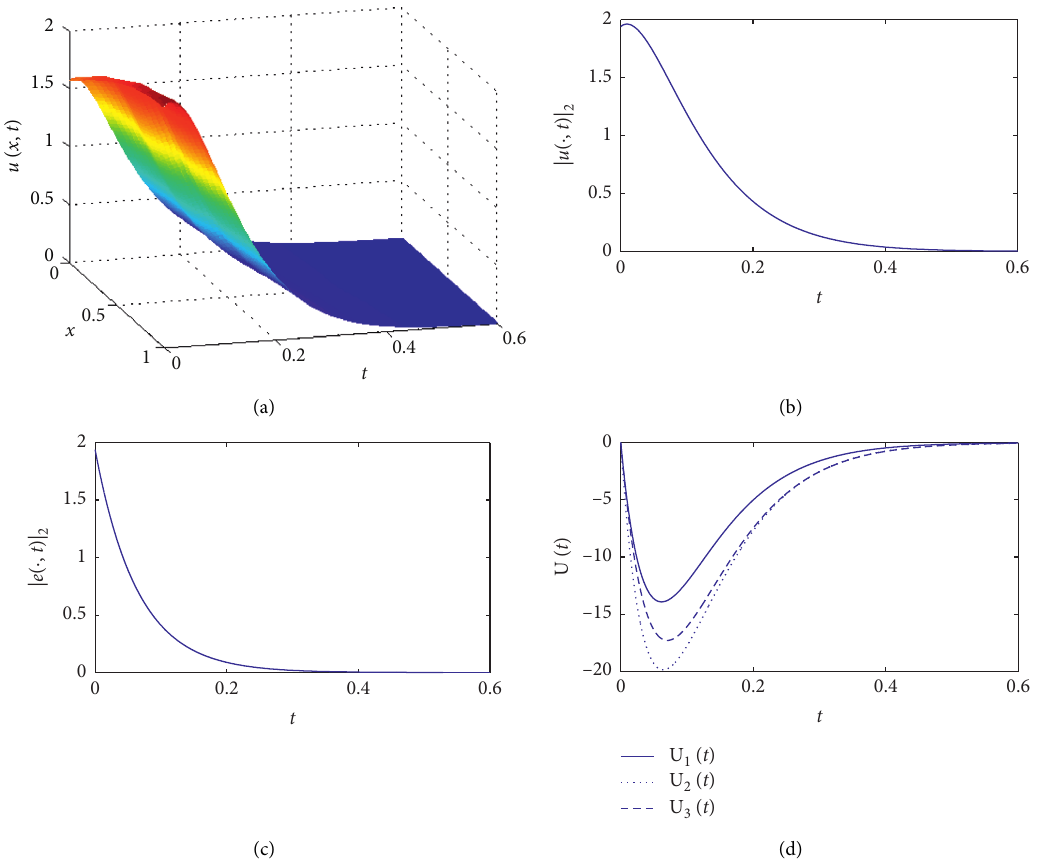
Figure 2: Closed-loop coupled DPS (18), (19), (7), and (9) with d ( z,t ) � 0 and ω ( t ) � 0 for local piecewise control and noncollocated local piecewise measurement in space. (a) Closed-loop profile of evolution of u ( z,t ) . (b) Closed-loop trajectory of | u (· ,t )| . (d) Trajectory of dynamic output feedback compensator U ( t ) trajectory of | e (· , t )| 2